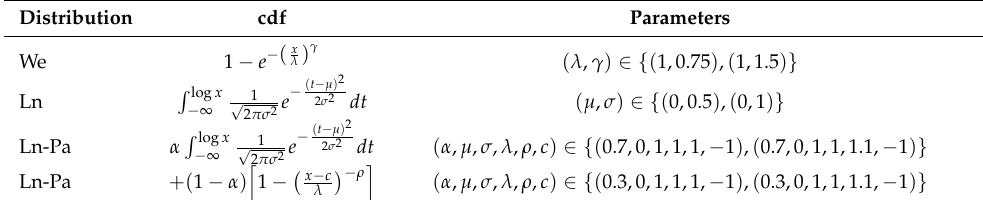
Table A1. Distributions in the simulation